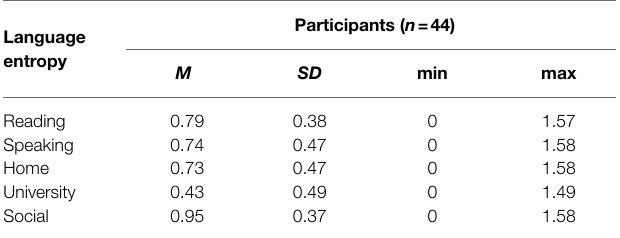
TABLE 2 | Mean language entropy scores for reading, speaking, home, university, and social contexts. Language